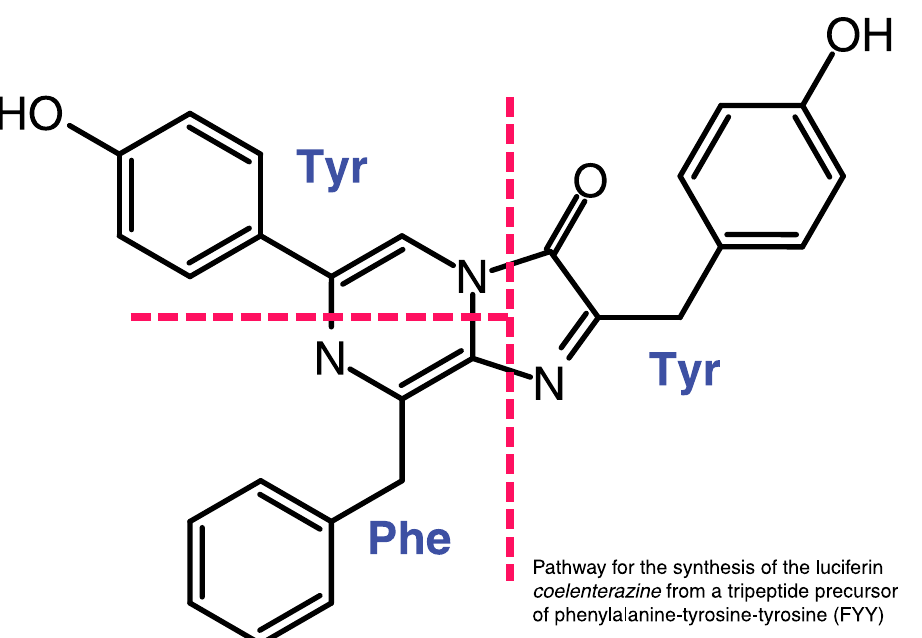
Fig 1. Structure of coelenterazine. Structure of coelenterazine showing the incorporation of the amino acids phenylalanine and tyrosine.